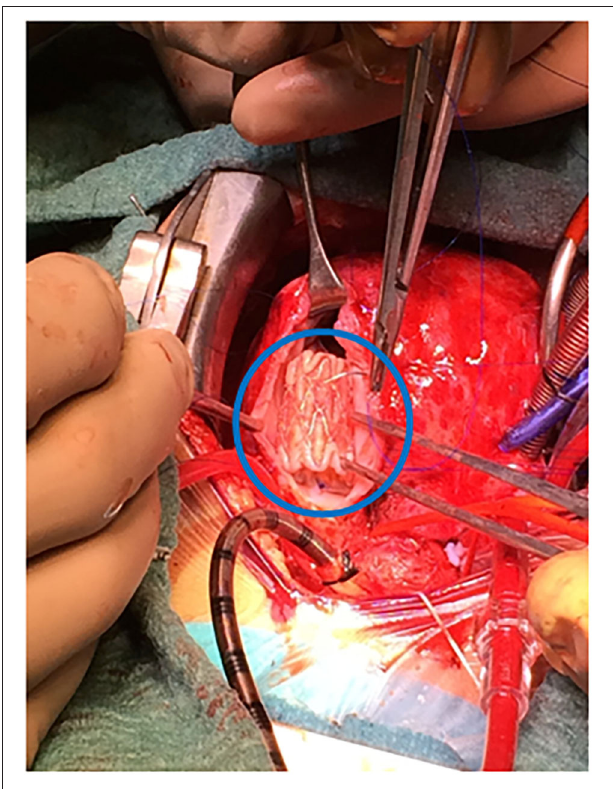
FIGURE 2 | Surgical insertion of melody valve (blue encircled) in an arrested heart on cardiopulmonary bypass.